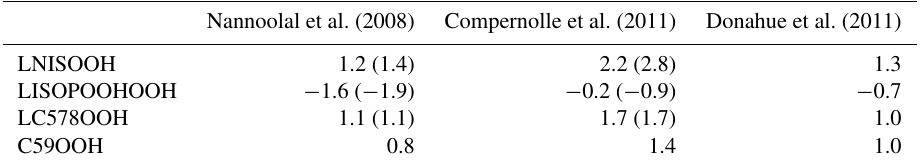
Table 5. Comparison of logarithmic saturation concentrations log 10 C ∗ at 300K for the iSOA precursors calculated via the group contribution 0 method used in RefBase (Nannoolal et al., 2008), used in EVA (Compernolle et al., 2011) and a simple group contribution method formulated by Donahue et al. (2011). In brackets the log 10 C ∗ values for the isomers are shown. 0